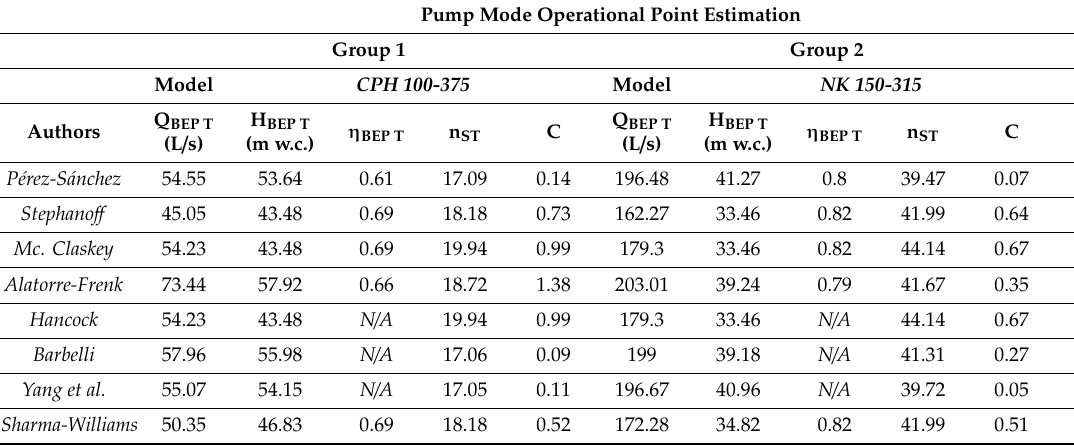
Table 14. Pump mode operation point estimation for each group of point #7.